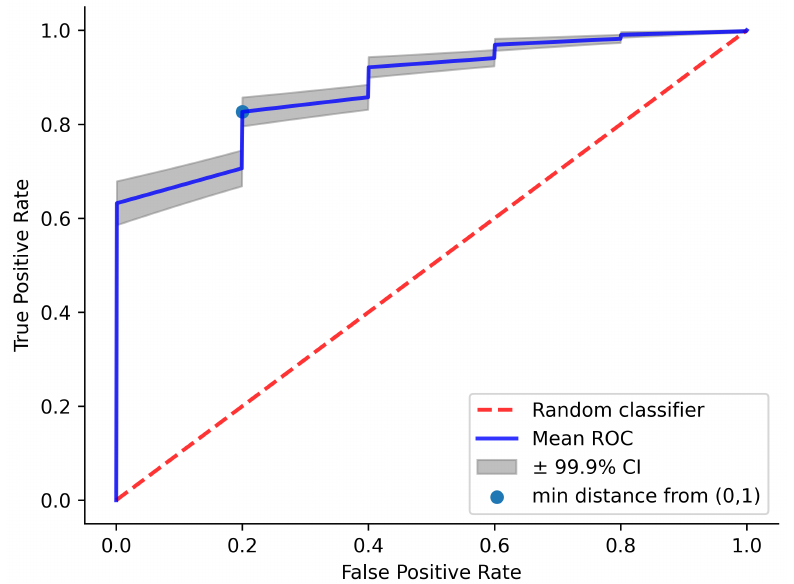
Figure 2. Average (and ± 99.9% confidence interval (CI)) ROC curve of the model trained in the classification task in a five-fold nCV over 100 repetitions using the ICBM dataset. The point in the ROC curve with the minimum distance from the ideal classifier (at coordinates (0,1)) is represented in blue (at coordinates (0.200, 0.826)). The ROC curve of a random classifier is overlayed in red as a